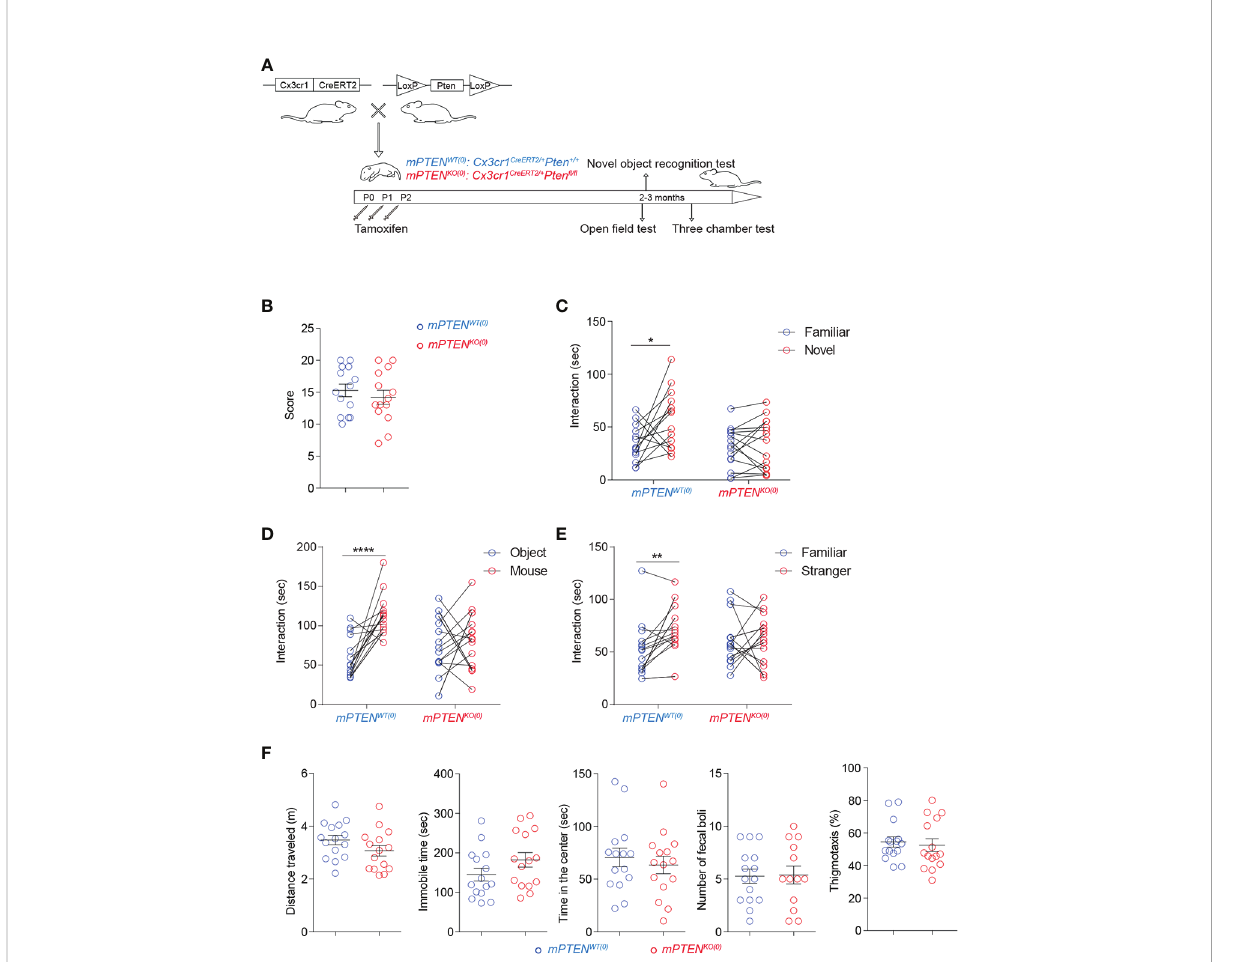
FIGURE 1 Postnatal Pten ablation in microglia leads to de fi cits in sociability and novelty exploration (A) Experimental scheme. (B) Numbers of marbles buried in 30 min during the marble-burying test (mPTEN WT(0) , n=14; mPTEN KO(0) , n=14). (C) Time spent exploring a novel versus a familiar object by mPTEN WT(0) (n=14) or mPTEN KO(0) (n=15) mice in the novel object recognition test. (D) Time spent interacting with an inanimate object or a mouse by mPTEN WT(0) (n=17) or mPTEN KO(0) (n=17) mice in the three-chamber interaction test. (E) Time spent interacting with a familiar or a stranger mouse by mPTEN WT(0) (n=17) or mPTEN KO(0) (n=17) mice in the three-chamber test. (F) Locomotor activities and thigmotaxis in the open- fi eld test. Total distance traveled (m), total time of being immobile (sec), total time of being in the center (sec), number of fecal boli left and thigmotaxis by individual mPTEN WT(0) (n=15) and mPTEN KO(0) (n=15) mice. * P < 0.05, ** P < 0.01, **** P < 0.0001, by unpaired (open fi eld and marble-burying) or paired (novel objection recognition and three-chamber interaction) t